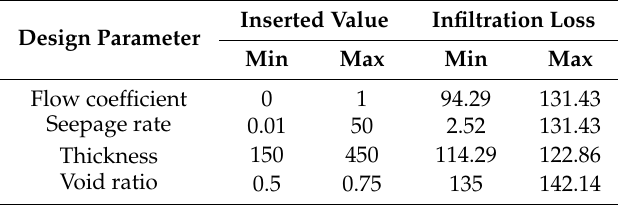
Table 3. Sensitivity analysis results for infiltration